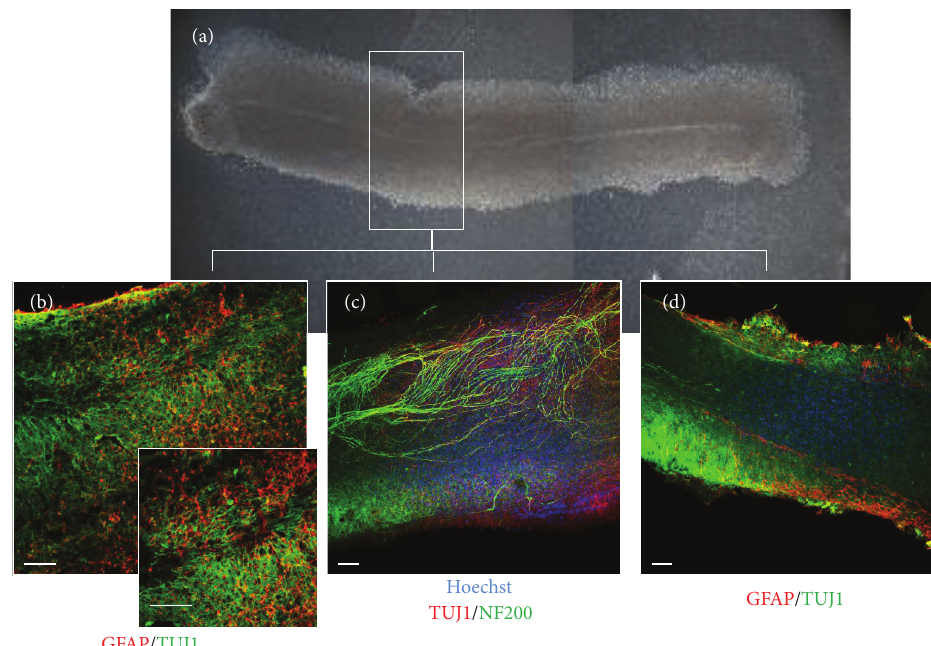
Figure 4: The intrinsic spinal cord axons forming a fiber tract. Two weeks after SCC preparation the anatomy of cultured slices was visualized by live imaging in light converted microscope (a) and by immunohistochemical analysis using neuronal and astrocytes markers ((b)–(d)). The scale bar is the equivalent of 200 𝜇